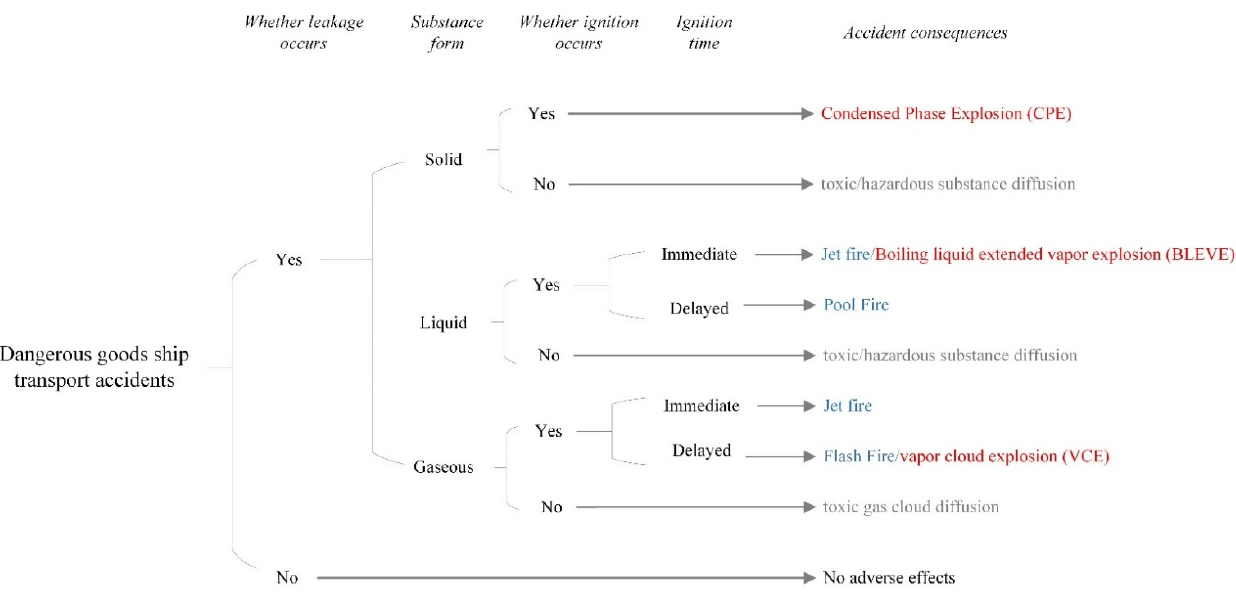
Figure 8. Event tree of an accident involving dangerous goods